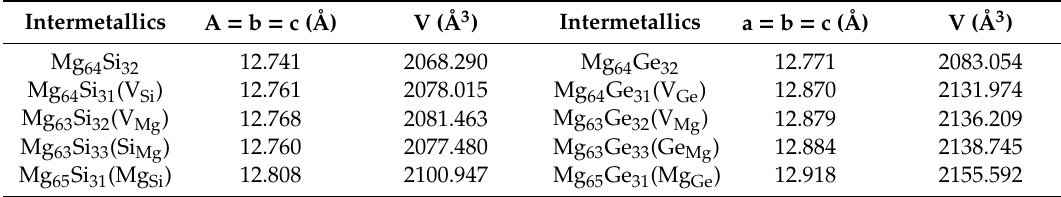
Figure 3. Comparison of lattice constants of Mg 2 X (X = Si, Ge) with point defects. Table 2. Calculated equilibrium lattice constants of 2 × 2 × 2 Mg 2 X (X = Si, Ge) cells with or without two types of point defects.